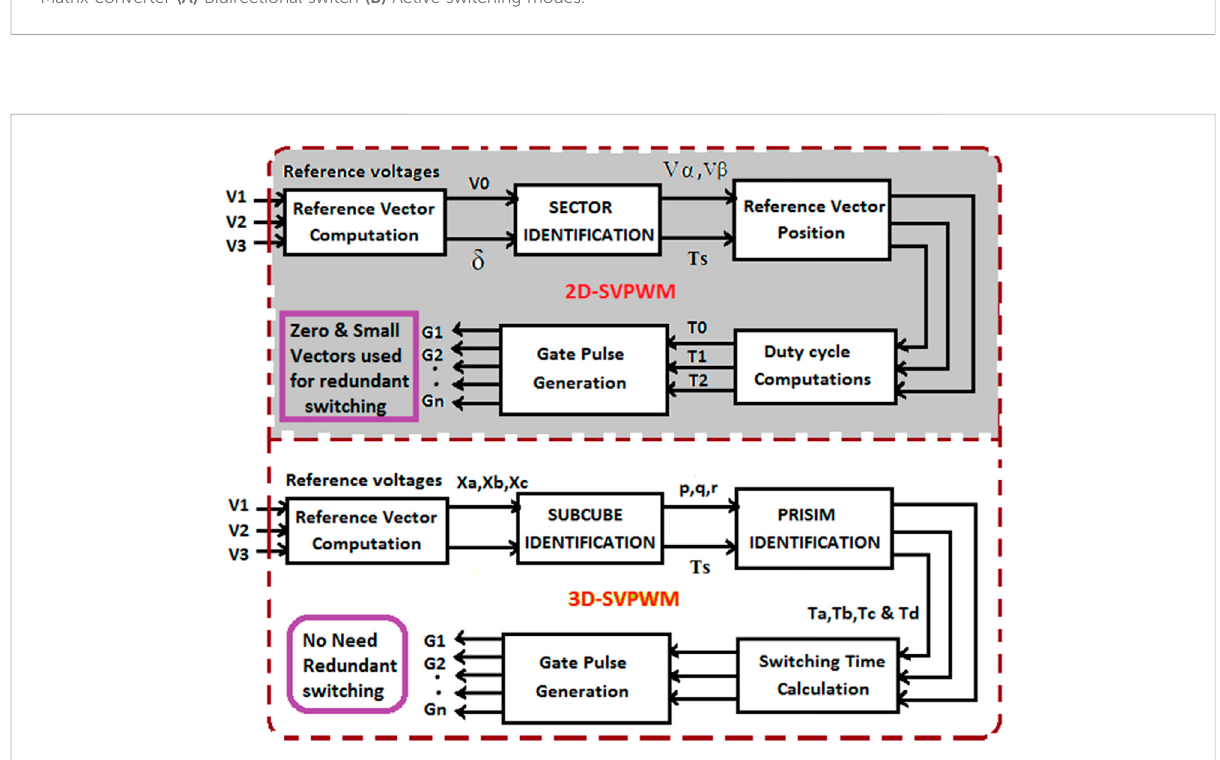
FIGURE 4 Comparison of switching pulse generation for 2D-SVPWM and